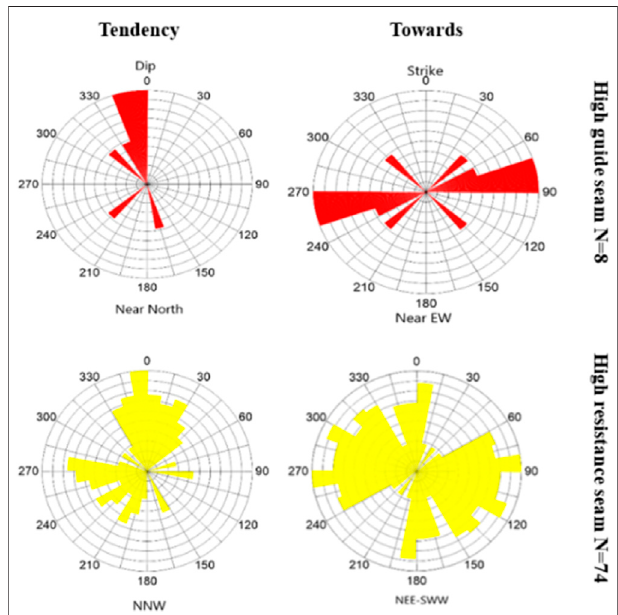
FIGURE 7 | Log interpretation of natural fracture development characteristics in yitan 3